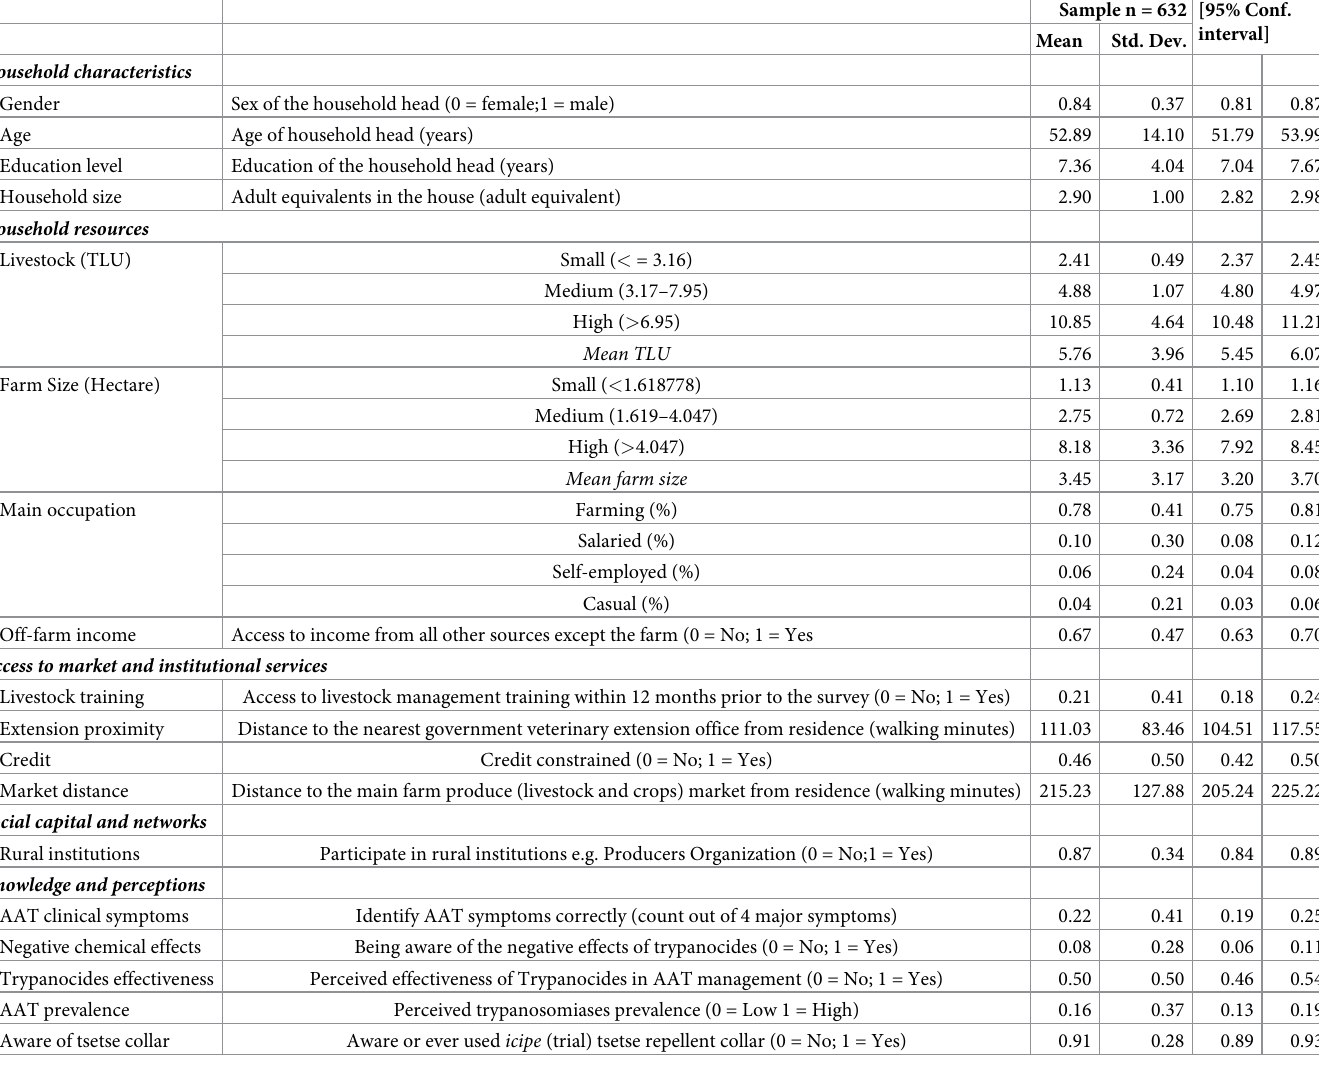
Table 1. Descriptive summary of socio-economic characteristics of the sampled cattle keepers in Kwale County.